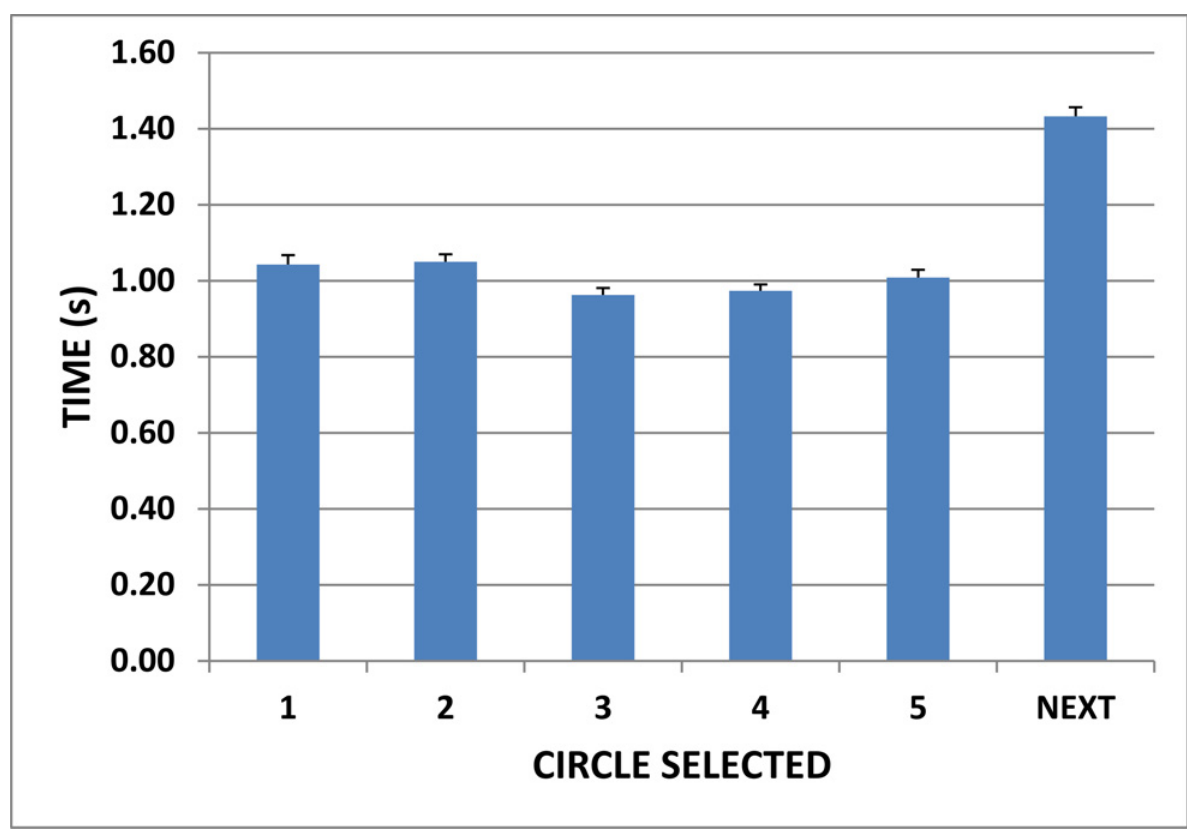
Fig 4. Mean item-selection latencies The latency of selection for circle 1 was measured from the beginning of the display, and latencies of each subsequent circle and the “ NEXT ” response were measured relative to the selection of the previous circle. Error bars show 95% confidence intervals. Data from successive correct 4-line patterns in Experiment